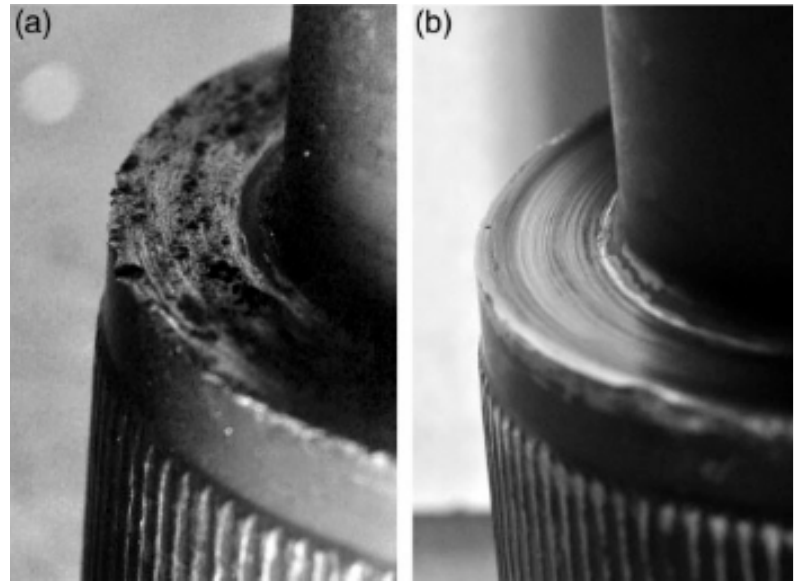
Figure 5. Underhead bearing surface of the bolt after ( a ) tightening without lubrication, ( b ) tightening with the ceramic paste [62].